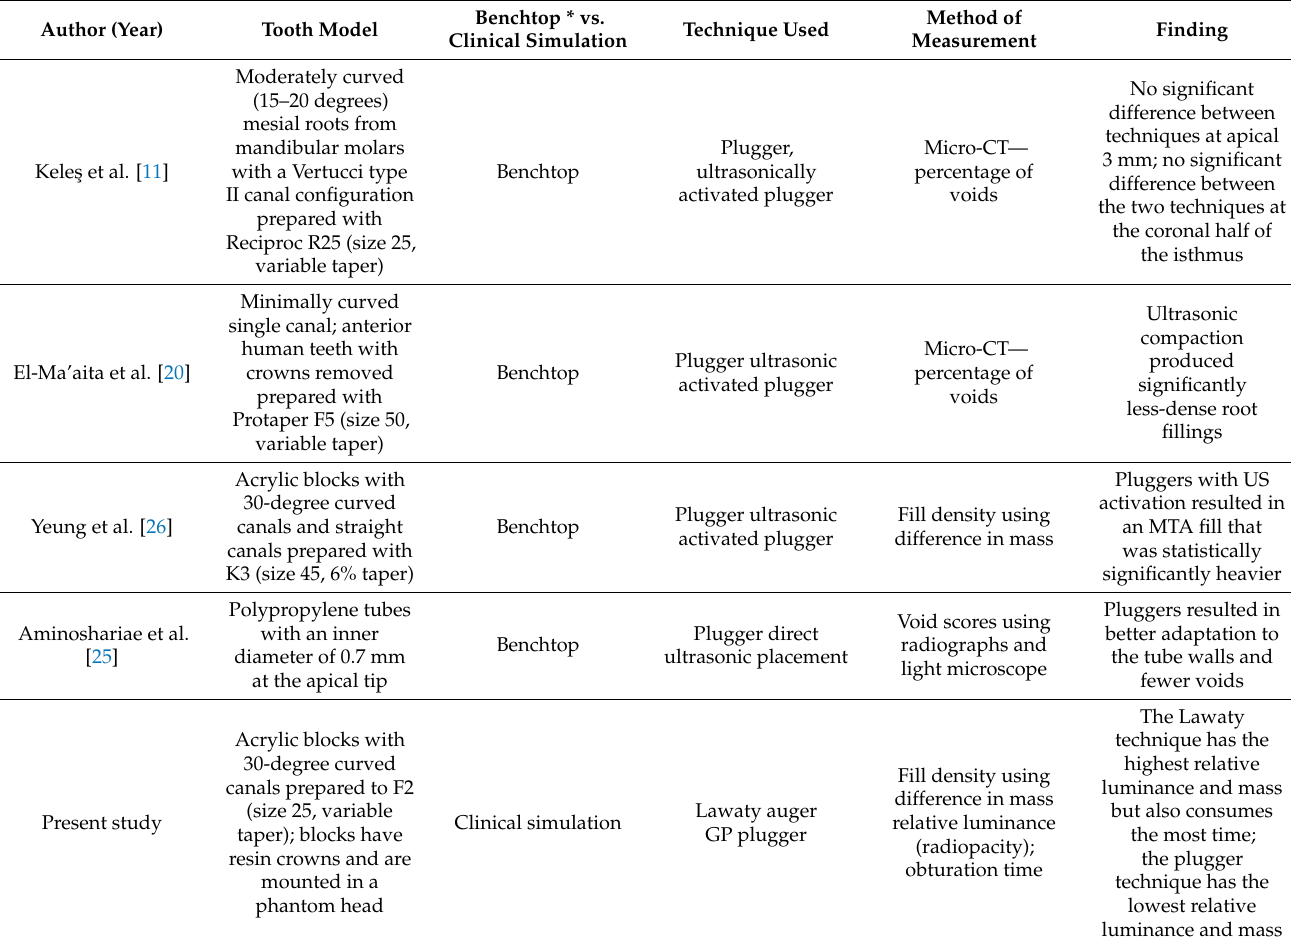
Table 4. Comparison of the methodologies and findings of existing